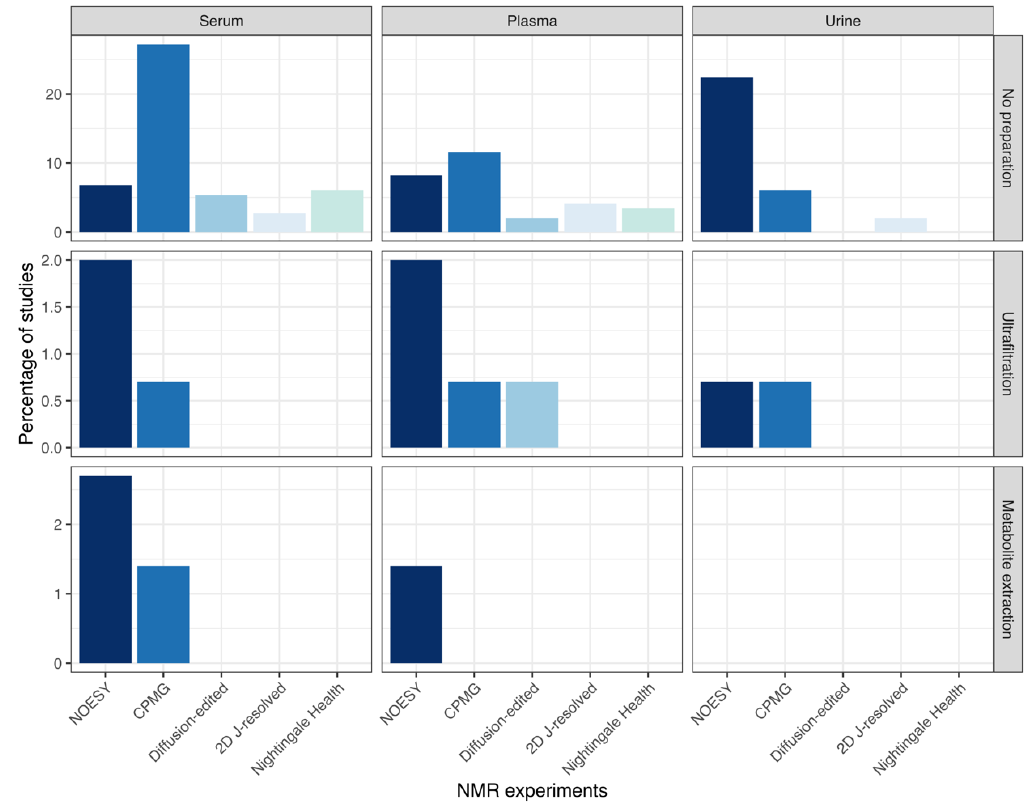
Figure 4. Bar graph showing how data are acquired on NMR. Different NMR experiments and the Nightingale Health platform used to generate NMR data from different sample preparation steps in serum, plasma, and urine